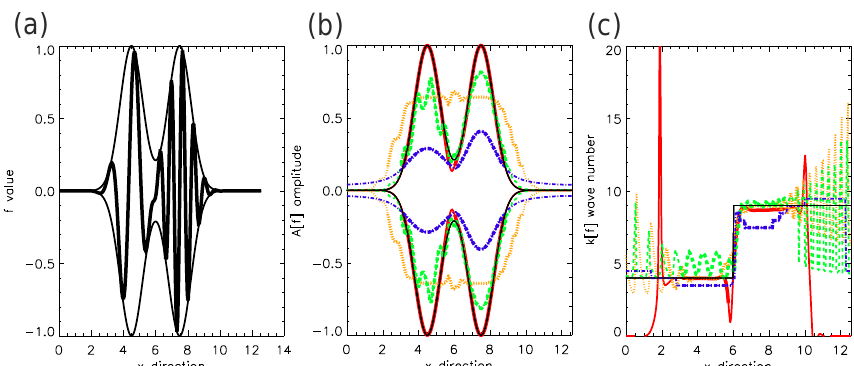
Figure 1. One-dimensional test function ( a , bold line) adapted from Zimin et al. (2003) and its envelope ( a , thin line). Comparison of amplitude (b) and wave number (c) calculated by different methods: UWaDi (solid, red), DIV (dotted, orange), S1-D (dashed, green), and 1-D ST (dash-dotted, blue). Valid estimates are drawn in